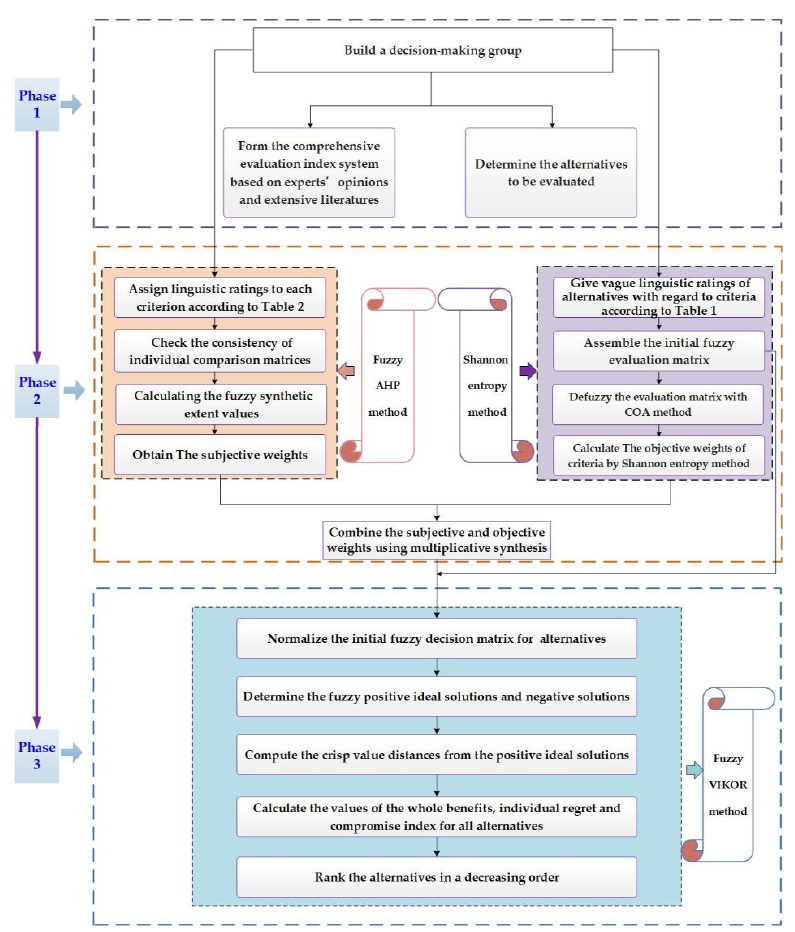
Figure 2. The research framework of the hybrid MCDM model for evaluating residential DR performance.